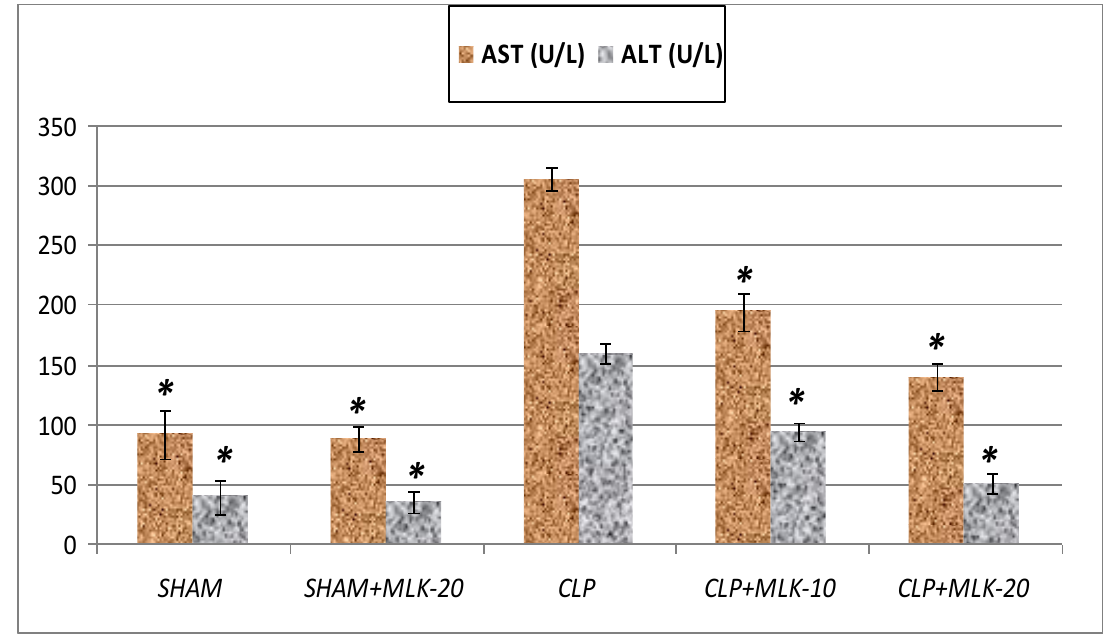
FIGURE 3. The effects of MLK on serum AST and ALT activities in CLP-induced septic rats. CLP: cecal ligation and puncture applied; MLK: montelukast treated; SHAM: sham operated. * Means significantly different at p < 0.05 when compared to CLP control